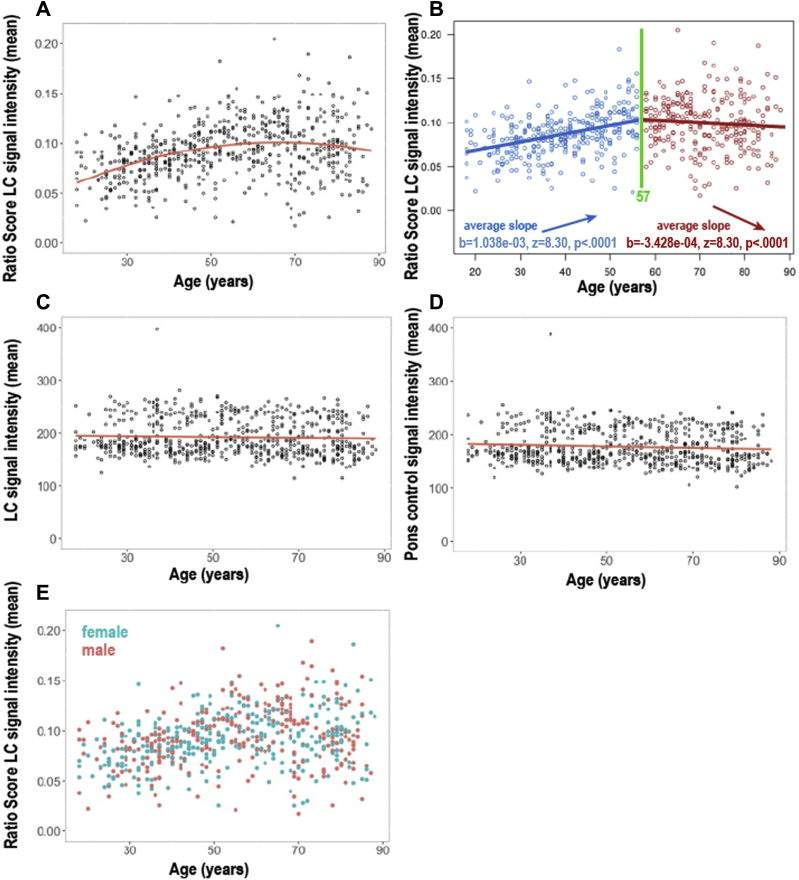
Graphs showing the relationship between mean LC CR (A, B, E), raw LC mean signal intensity (C), or mean pontine reference region signal intensity (D) and age in years. Unfilled circles (A, B, C, D) represent individual data points (n = 605); solid red circles represent males (n = 295) and solid blue circles represent females (n = 310) (E). In A, a quadratic model (adjusted R2 = 0.126, p < 0.001) provided a better fit than a linear model (adjusted R2 = 0.086, p < 0.001) according to the AIC. The quadratic relationship remained significant (adjusted R2 = 0.181, p < 0.001) after controlling for reference region signal intensity and TR scan parameter (30 or 50 ms). In (B), a post hoc “two-lines” test (proposed to be a valid alternative to testing a U-shaped relationship) provided a breakpoint of 57 years but the second slope was not individually significant (p = 0.92); not fully supporting the presence of a U-shaped relationship between LC CR and age. This may have been related to a smaller age range and higher variance (F = 1.46, p < 0.001) in the “older” (>57 years) versus “younger” group (<57 years). C shows a nonsignificant, weak, negative linear relationship between the raw LC signal intensity mean scores and age (r = −0.039, adj R2 = 0.0002, p = 0.341) and (D) shows the observed significant negative linear relationship between reference region (pontine) signal intensity and age (r = −0.1, adj R2 = 0.005, p = 0.049). In (E), no significant difference in mean LC CR was found between males (n = 295, solid red circles) and females (n = 310, solid blue circles) using a Bayesian approach. Abbreviations: LC, locus coeruleus; CR, contrast ratio; TR, repetition time; AIC, Akaike information criterion. (For interpretation of the references to color in this figure legend, the reader is referred to the Web version of this article.)